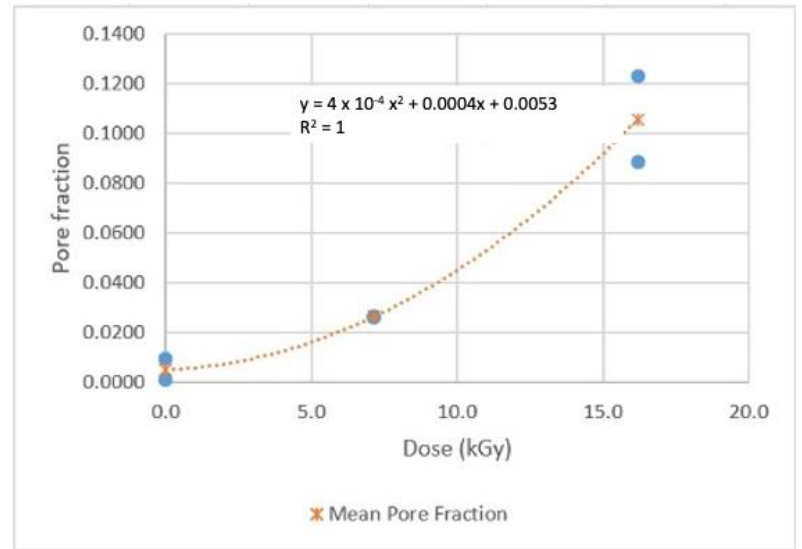
Figure 26. Porosity (pore fraction) of the 0 – 16 kGy wafer samples.